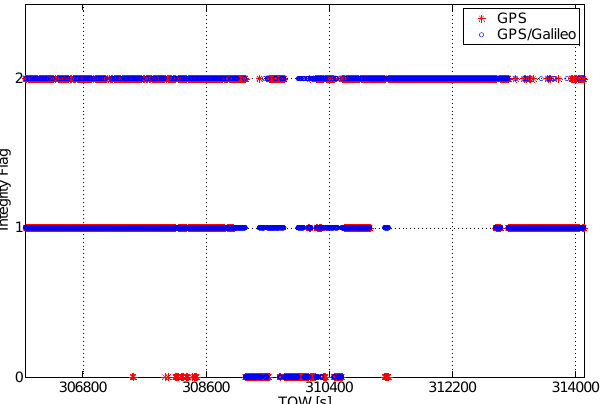
Figure 14. Integrity flag as a function of time. The flag is set to zero when it is not possible to test the reliability of the solution; one implies a reliable solution; two indicates an unreliable solution.